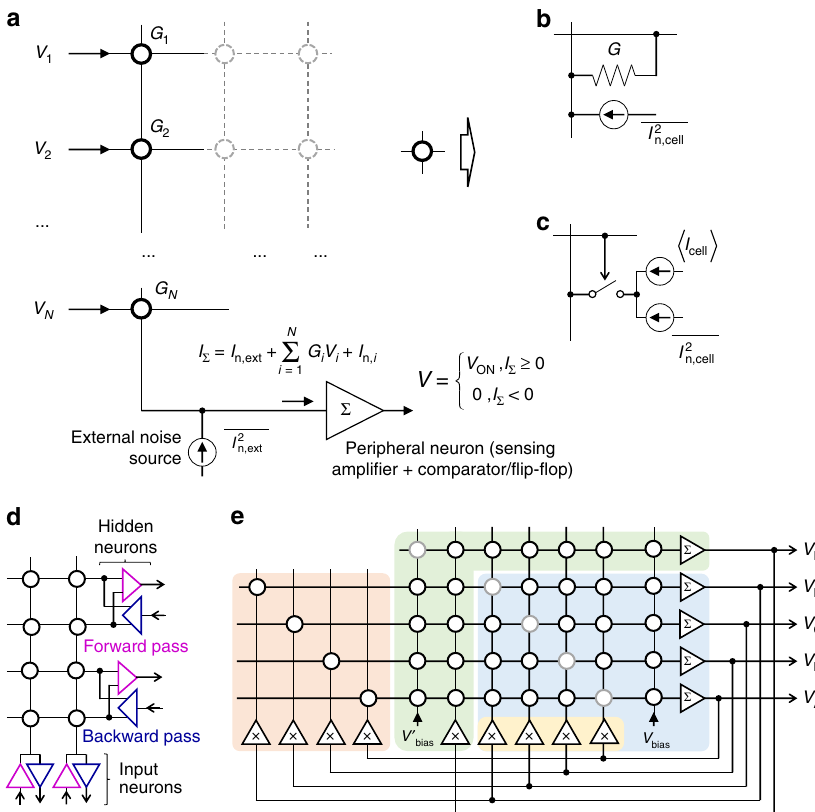
Fig. 1 Stochastic dot-product circuit and its applications in neurocomputing. a Circuit schematics for the design with current-mode sensing with crosspoint device implementation based on ( b ) memristors and ( c ) fl oating-gate memories. The equations in fi gure corresponds to memristor implementation, while their modi fi ed version for fl oating-gate design are described in text. d An example of the considered differential-pair Boltzmann machine implementation. e The implementation of generalized Hop fi eld neural network. The blue background highlights the baseline implementation. The yellow, green, and red backgrounds highlight additional circuitry for the proposed “ stochastic ” , “ adjustable ” , and “ chaotic ” approaches, respectively. The gray shaded circles show synaptic weights which are typically set to zero. Labels “ Σ ” / “ x ” inside ampli fi er symbols denote summation / scaling. For clarity, panel a does not show bias currents, panels ( a ) and ( e ) show single-ended network, while panel ( d ) shows ( a ) small two-input, two-hidden neurons fragment of the considered